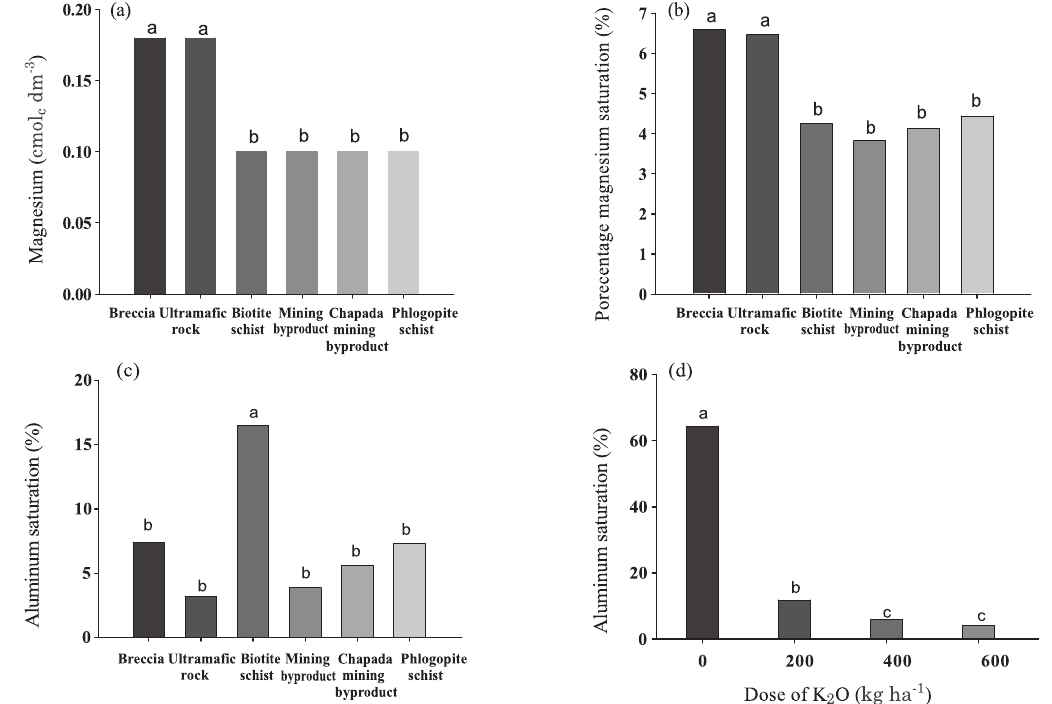
figure 5. soil mg availability (a) and saturation (b), al saturation (c) as related to ultramafic rock, biotite schist, mining byproduct, Chapada mining byproduct, and phlogopite schist, with the respective fertilizer rate. al saturation (d) as related to k 2 o levels (average of alternative